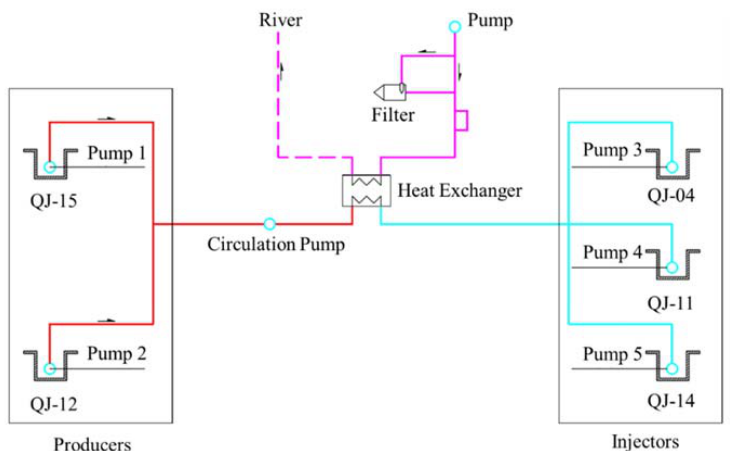
Figure 3. Tracer test illustration. Blue lines are lower temperature water and red lines represents warmer water.